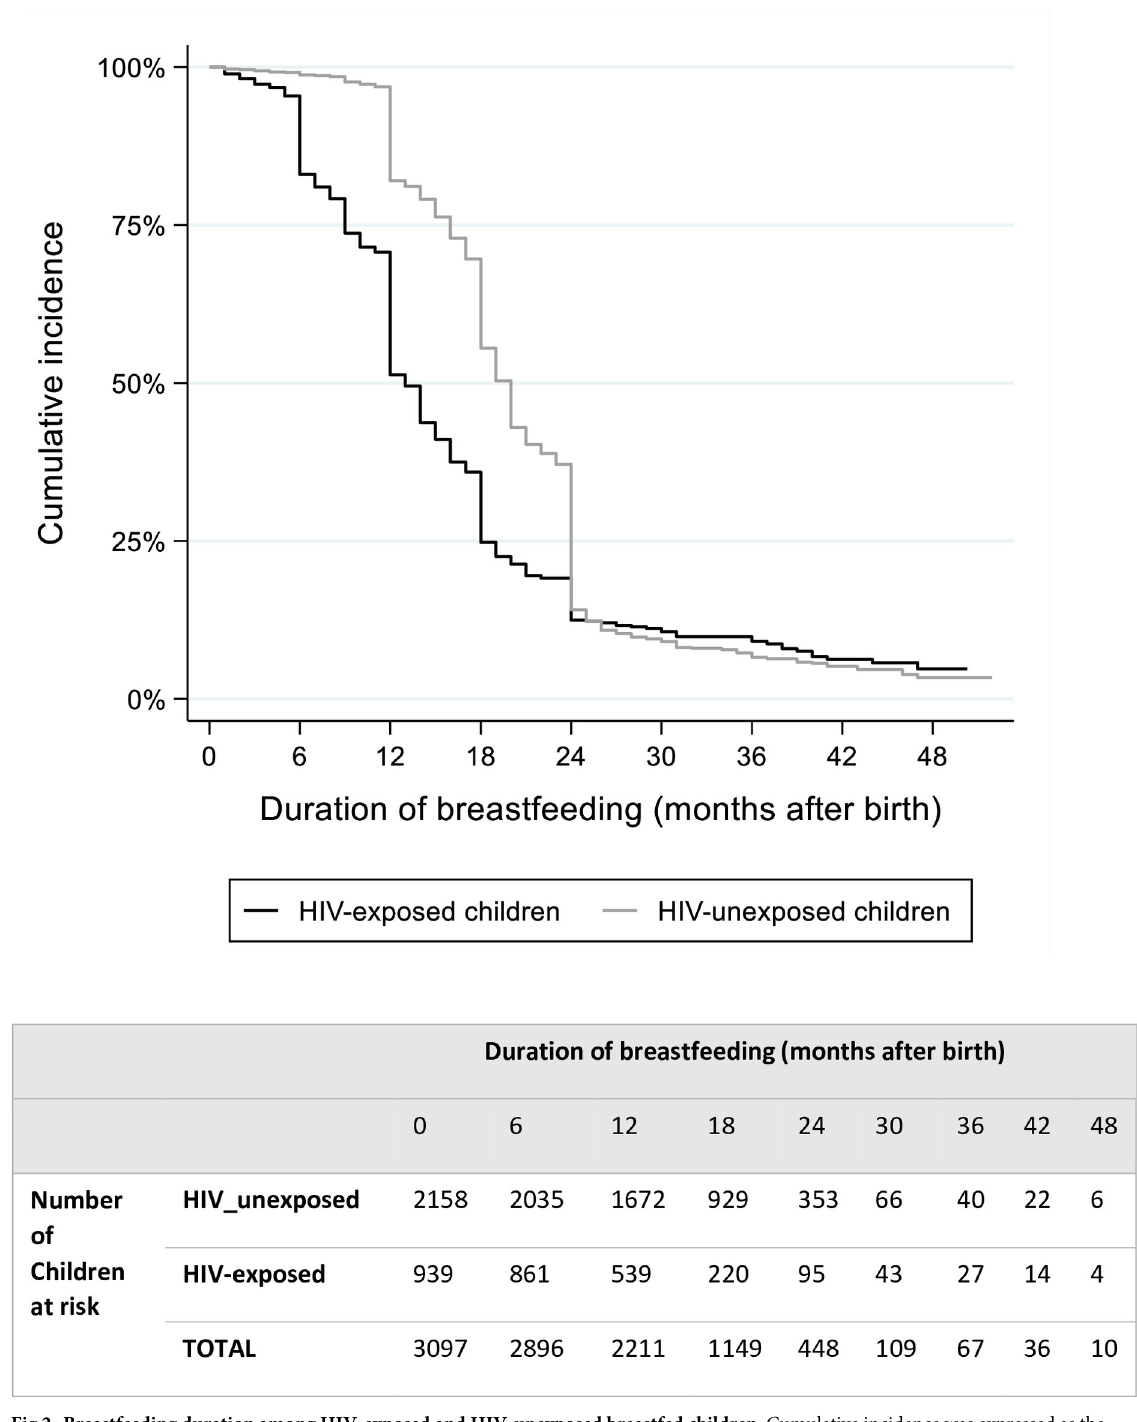
Fig 2. Breastfeeding duration among HIV-exposed and HIV-unexposed breastfed children. Cumulative incidence was expressed as the proportion of children breastfeeding in a given time period after birth accounting for right censoring and adjusted by sex and age of the child. Children who had not initiated breastfeeding were excluded from this analysis. N = 3097.